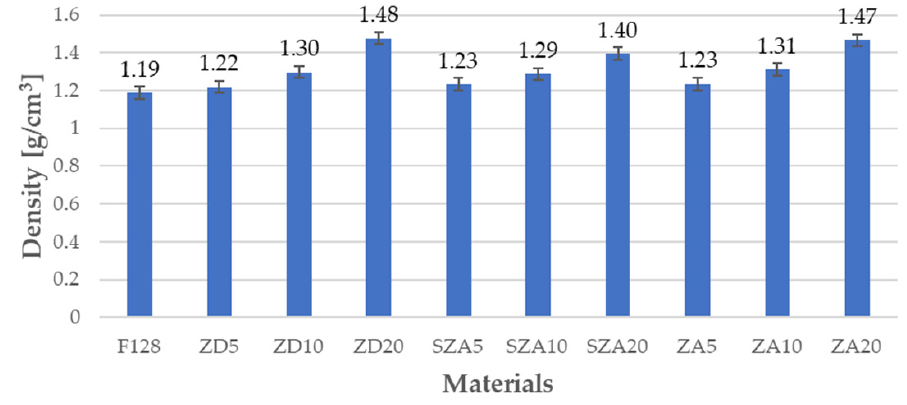
Figure 2. Densities of the tested materials determined by the hydrostatic weighing method. Material F128